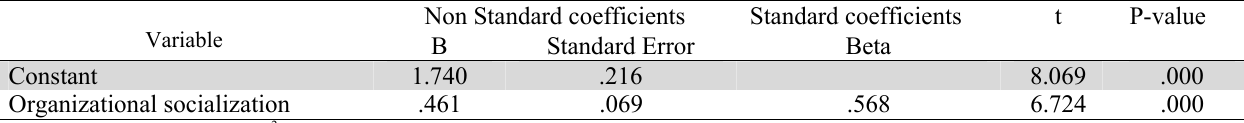
Result of linear regression analysis of Organizational socialization and organizational commitment Non Standard coefficients Standard coefficients t Variable